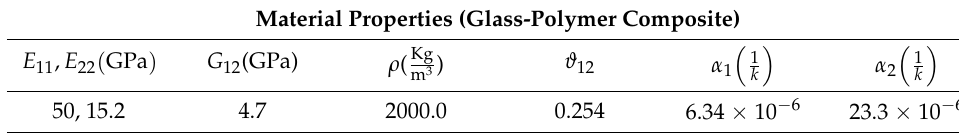
Table 2. Material properties of the composite layers [43].